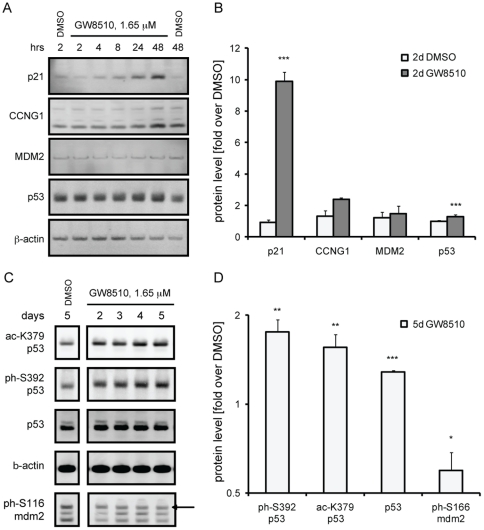
GW8510 treatment effects on protein levels of p53 transcriptional targets and on post-translational modification status of p53 and MDM2.(A) Western blot analysis and (B) quantification of protein levels of direct p53 targets following a two-day time-course with 1.65 µM GW8510. (C) Western blot analysis and (D) quantification of total protein and post-translational modification levels following 2–5 days of treatment with 1.65 µM GW8510. Data represent the mean ± SD of 3 biological replicates; *p<0.01, **p<0.01 and ***p<0.001.